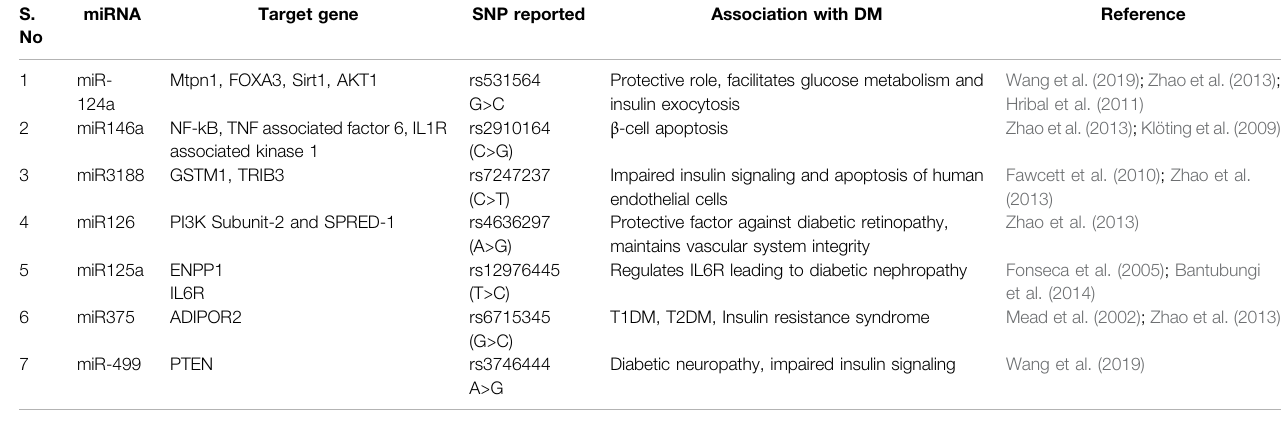
TABLE 3 | SNPs reported in seed sequence of miRNA involved in diabetes.